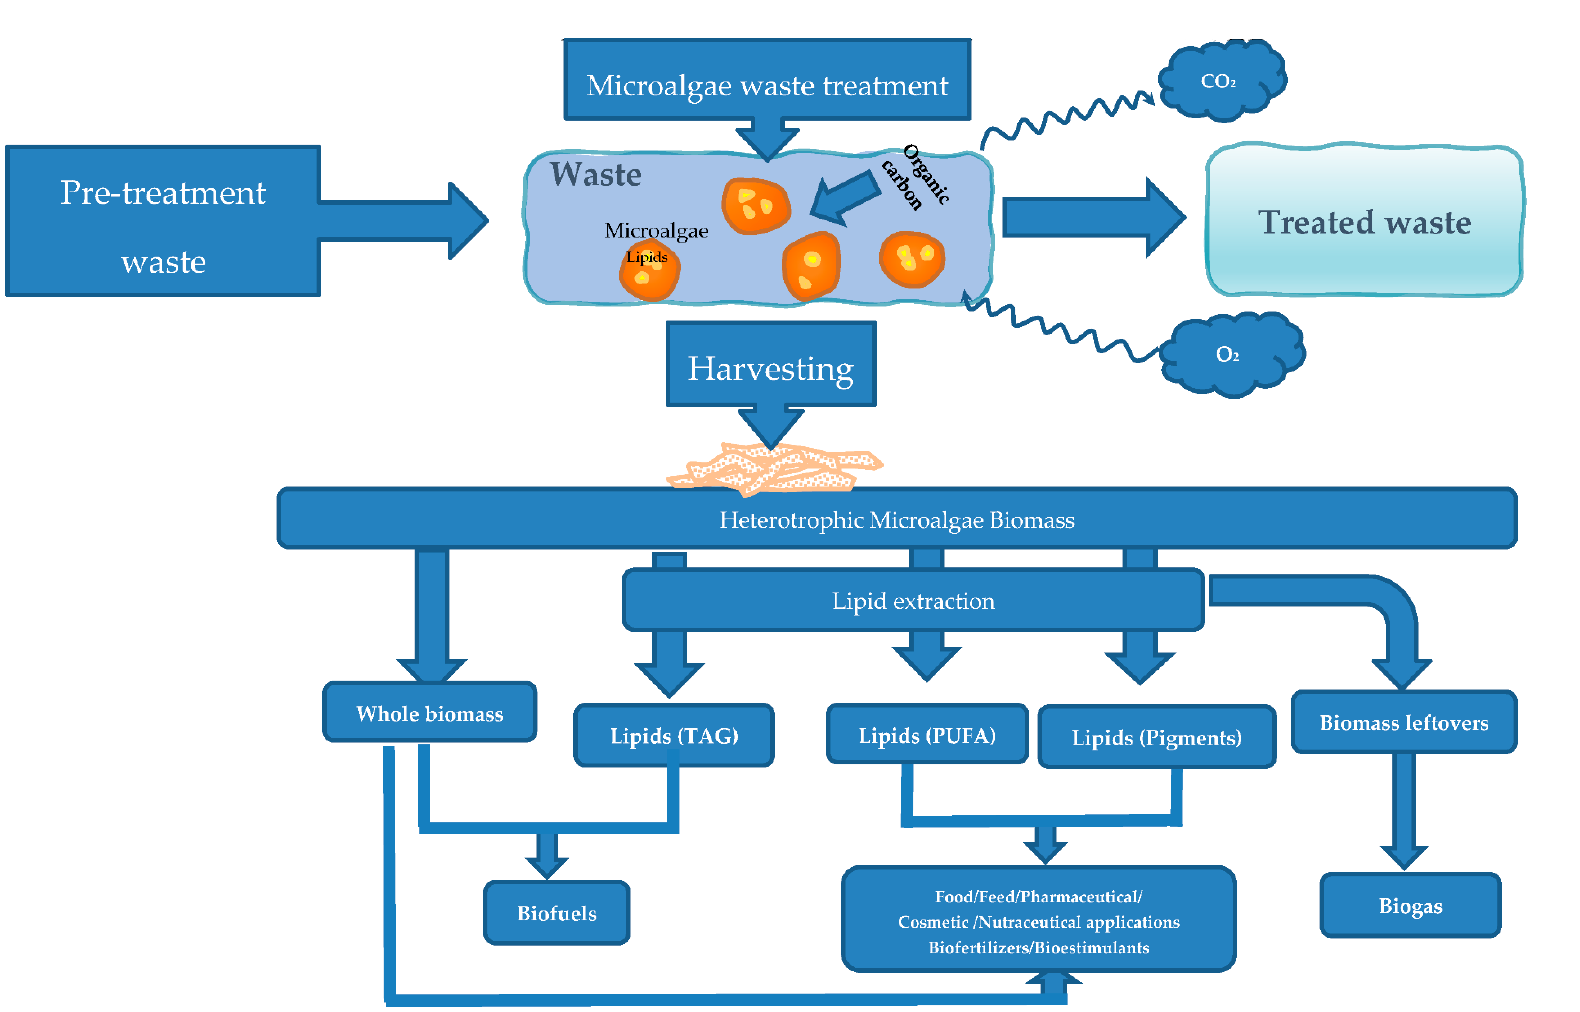
Figure 1. Heterotrophic metabolism and microalgal biomass applications.